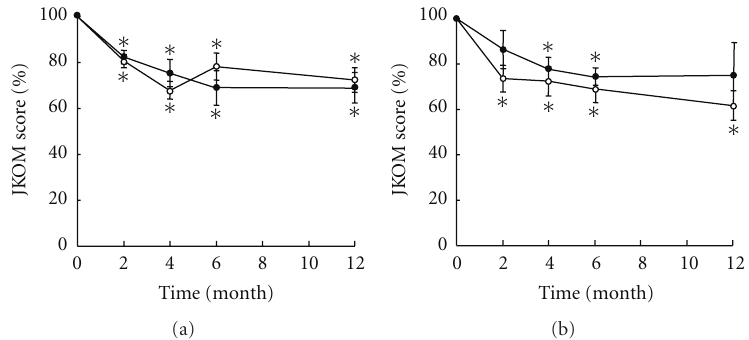
Figure 2: Change in JKOM score with respect to disease severity. Subjects were divided by the Kellgrel-Lawrence (K/L) grade determined on radiographs, and changes in the total JKOM score are shown in respective groups by change rates relative to scores at baseline. Results of subjects with K/L grade 2 knee OA (A) and those with K/L grade 3 OA (B) are shown. Open and closed circles indicate change rates of subjects given HA and placebo, respectively. Results are mean ± SE of 9 to 11 subjects. ∗ P < 0 . 05 against